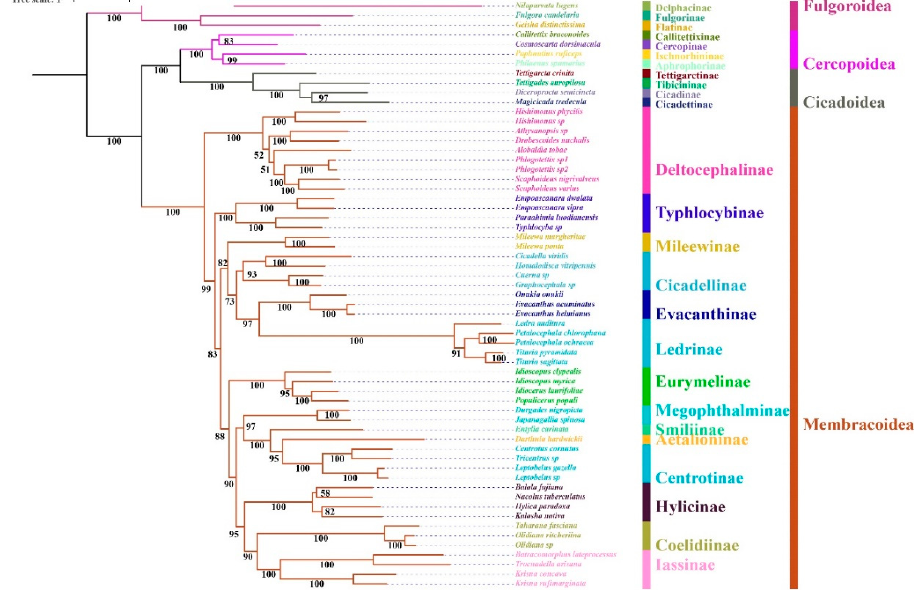
Figure 7. Maximum likelihood tree inferred from the dataset of PCG using IQ-TREE. Node numbers show bootstrap support values.